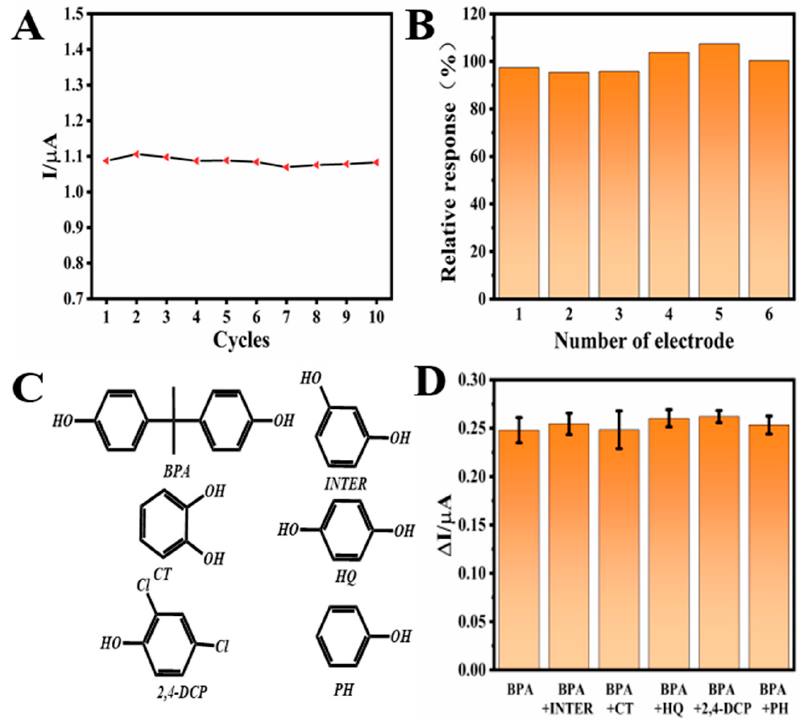
Figure 6. ( A ) Stability of β -Bi 2 O 3 -based MIP-PEC sensor. ( B ) Reproducibility of the β -Bi 2 O 3 -based MIP-PEC sensor. ( C ) The structural formulas of the interferents. ( D ) Selectivity of MIP/ β -Bi 2 O 3 /ITO to BPA and interferents. The concentration of BPA was 10 nM, and the interferents were at a concentration of 100 nM.